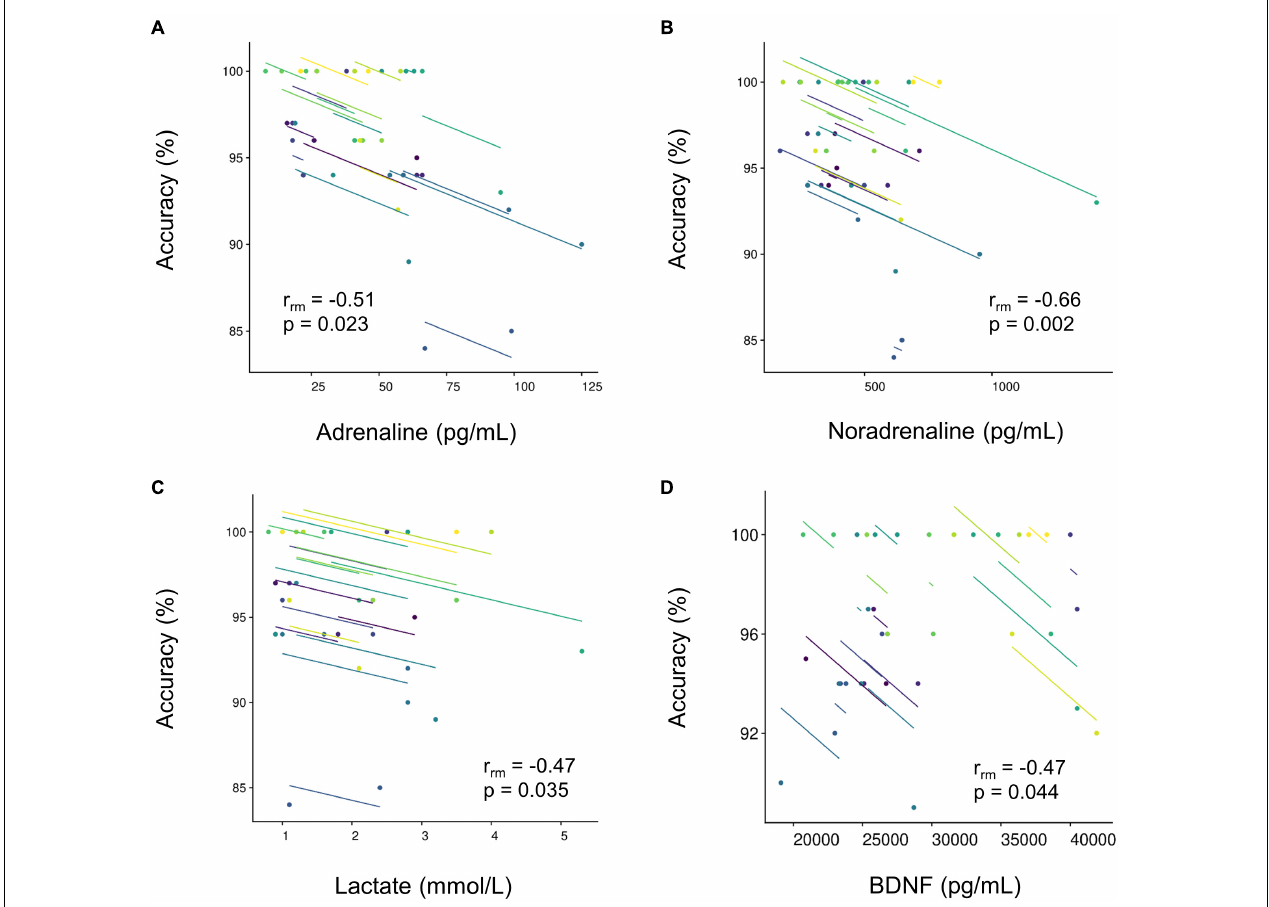
FIGURE 2 | Repeated measure correlations between the accuracy of the Go/No-Go task and peripheral circulating biomarkers [ (A) adrenaline, n = 19; (B) noradrenaline, N = 19; (C) lactate, N = 19; and (D) brain-derived neurotrophic factor, N = 18] in the resistance condition. Plots represent individual data. Lines show the r rm fit for the participants. Same colors represent data from the same